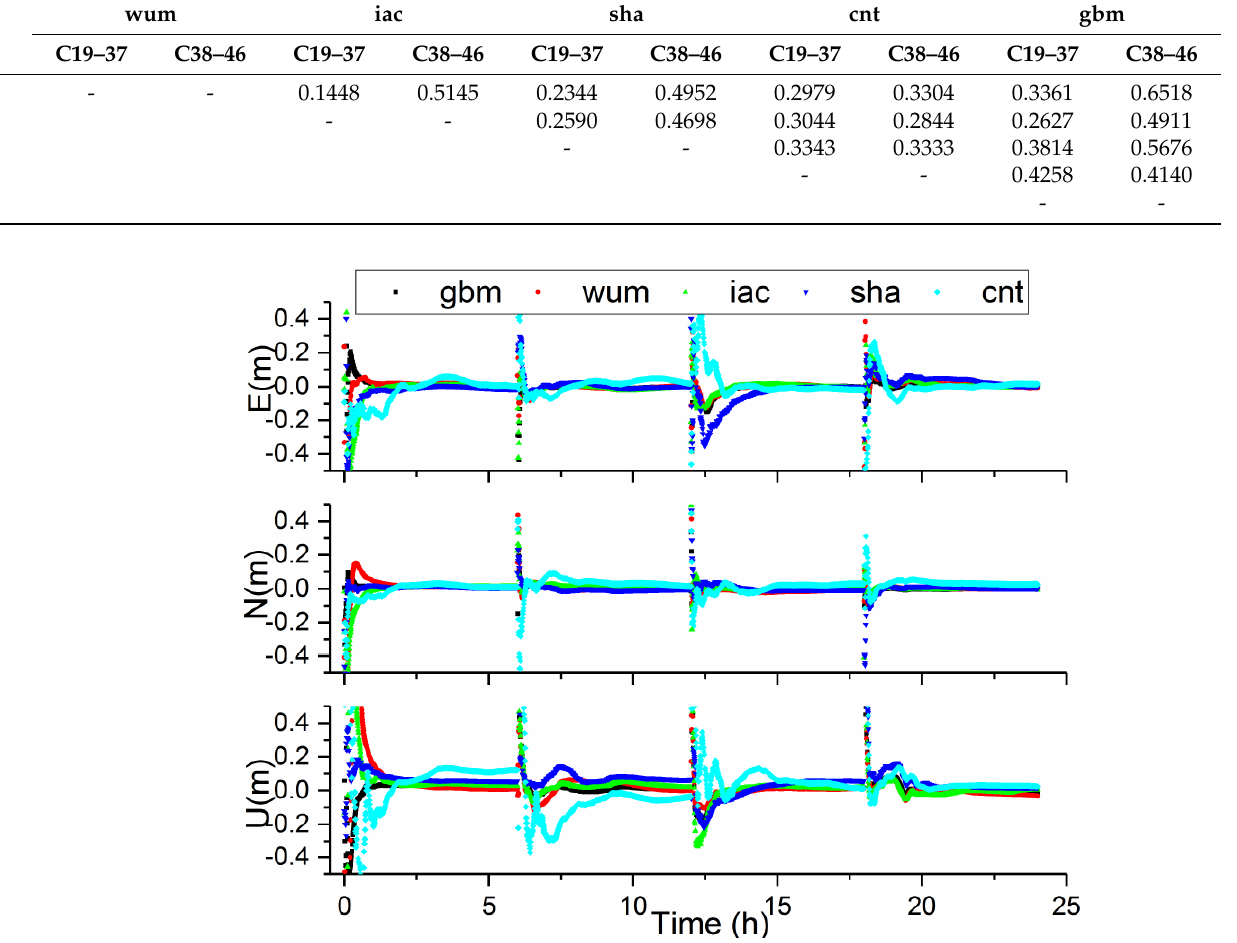
Figure 4. Positioning errors obtained from BDS-3 PPP in static mode with different products on DOY 288 at